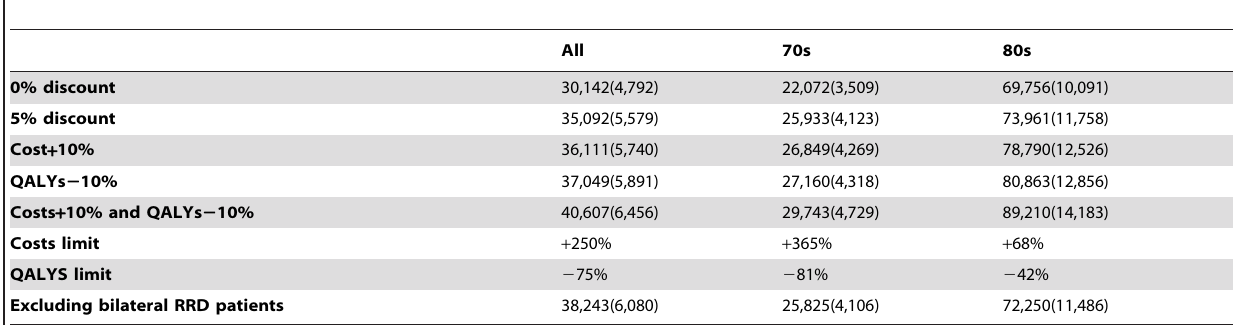
Table 6. A summary of ICERs (CNY (USD)/QALY) in sensitivity analyses for RRD surgery in an elderly population (n=98).